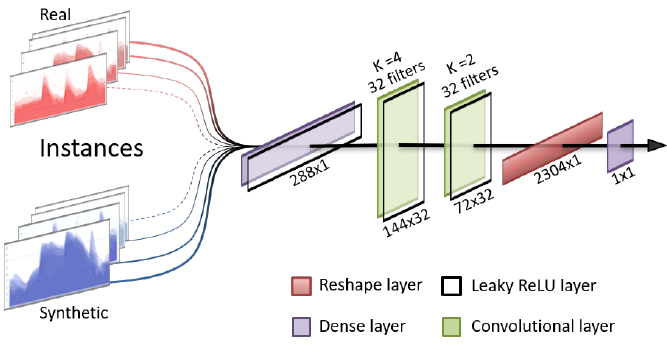
Figure 2. Graphical representation of the discriminator